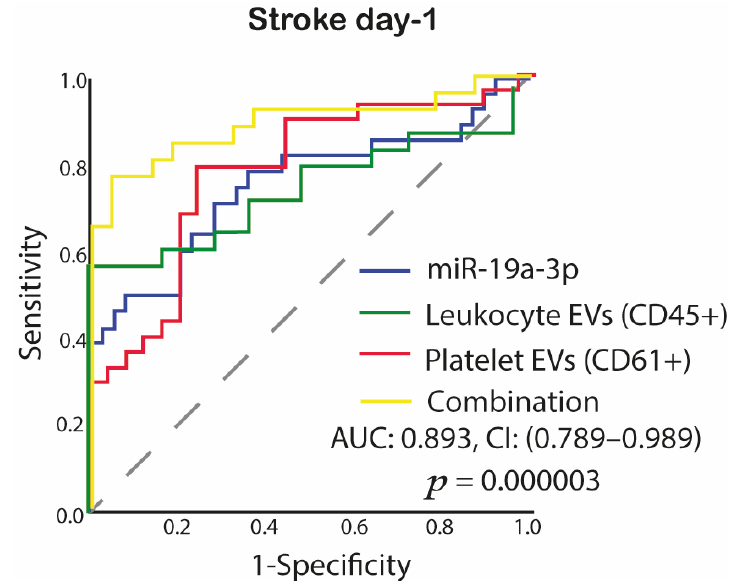
Figure 6. The ROC curve evaluates the diagnostic value of combined miRNA and EVs in the model in acute IS. ROC curves of the three significantly deregulated studied biomarkers (miR-19a-3p, leu- kocyte-EVs and platelet EVs) showed high diagnostic accuracy. Abbreviations: EVs, extracellular vesicles; miR, microRNA; p , value; AUC, area under the curve; CI, confidence interval; ROC, Re- ceiver operating characteristic.